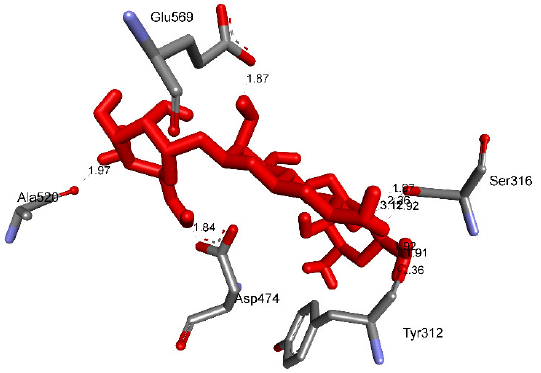
Figure 22. The hydrogen bonds from pose 172, apramycin, a standard drug used for antimicrobial activity, to enzyme 2VF5.